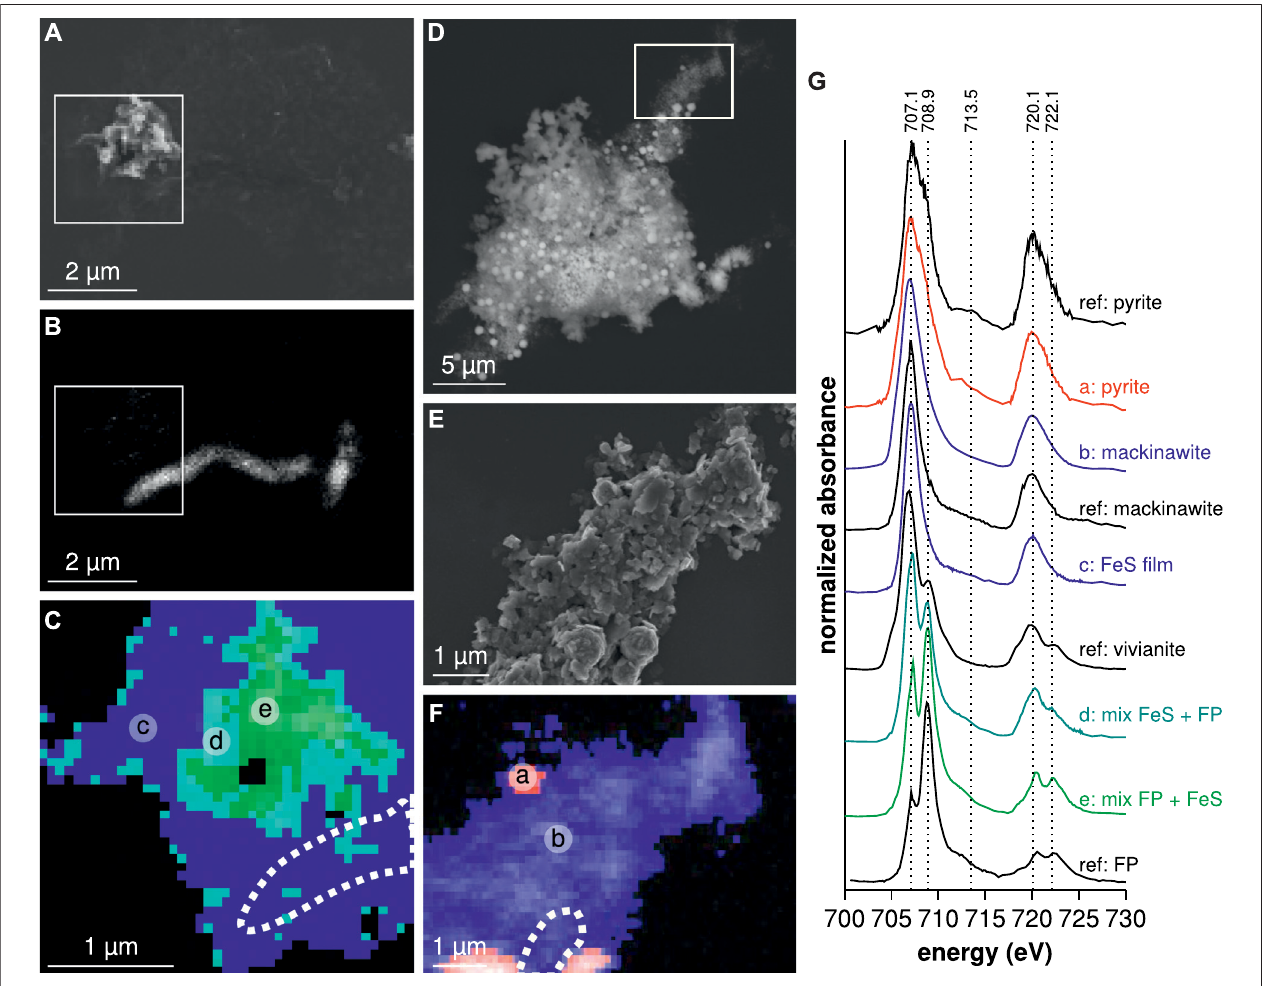
FIGURE 5 | SEM and STXM observations in FP-nano condition after 1 week and 6 months. (A) Secondary electron image at 1 week of bacteria embedded in the ironsul fi de fi lmclosetoanFe III -phosphateparticle. (B) STXM CK-edgemapofproteins obtainedbysubtractingtheimageat270 eVfromtheimageat287 eVrevealing bacteriafrom (A) . (C) STXMFeL 2 , 3 -edgescompositemapoftheareasquaredin (A,B) . (D) Backscatteredelectronimageat6 monthsofmultiplepyritespheruleswithin a mackinawite aggregate. (E) Secondary electron image of the area delineated in (D) . (F) Fe L-edges composite map of (E) . Dotted line showed bacteria revealed by scanning transmission X-ray microscopy C K-edge data. (G) Scanning transmission X-ray microscopy spectra pinned from previous composite maps. Letters in composite maps correspond to scanning transmission X-ray microscopy spectra provided in (G) .